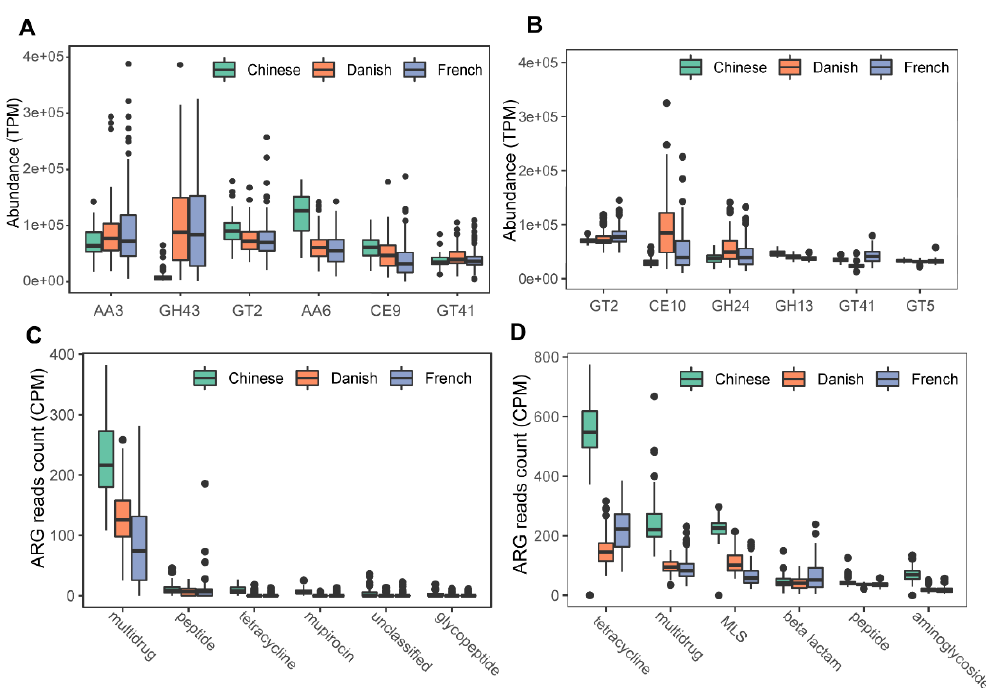
Figure 6. Summary of predominant CAZyme gene families ( A , B ) and antibiotic resistance genes ( C , D ) of archaea and bacteria in pigs. The top six CAZy gene families of archaea ( A ) and bacteria ( B ) were normalized by TPM (trans per million) using salmon software. ARG raw counts were identified using deeparg software. The ARG reads count of archaea ( C ) and bacteria ( D ) were normalized by CPM (counts per million).